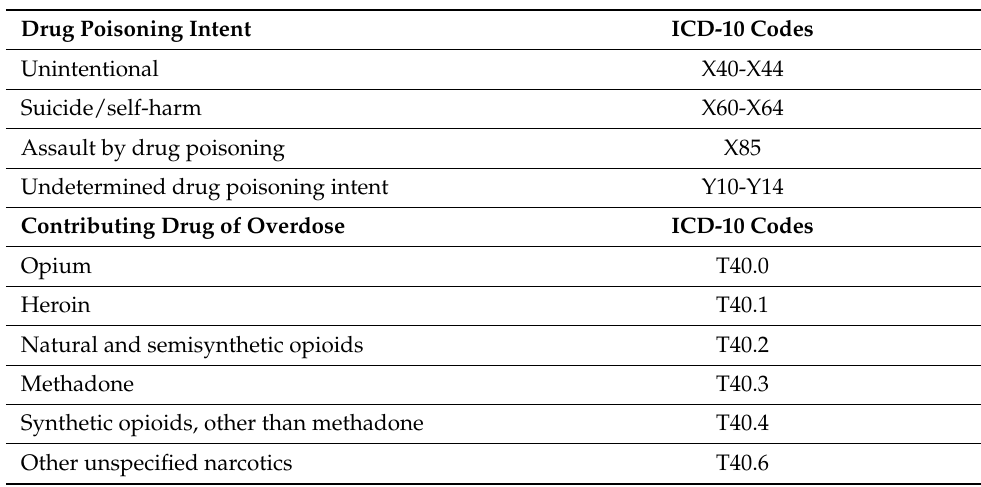
Table A2. Description of opioid-related ICD-10 death